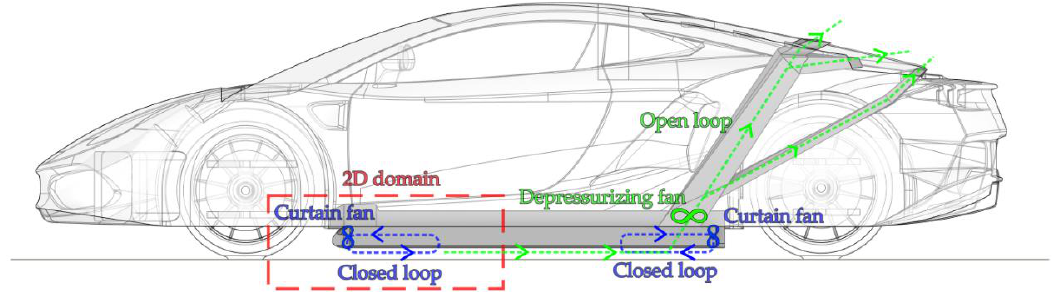
Figure 3. Computational domain of a planar 2D model in the context of a car model.